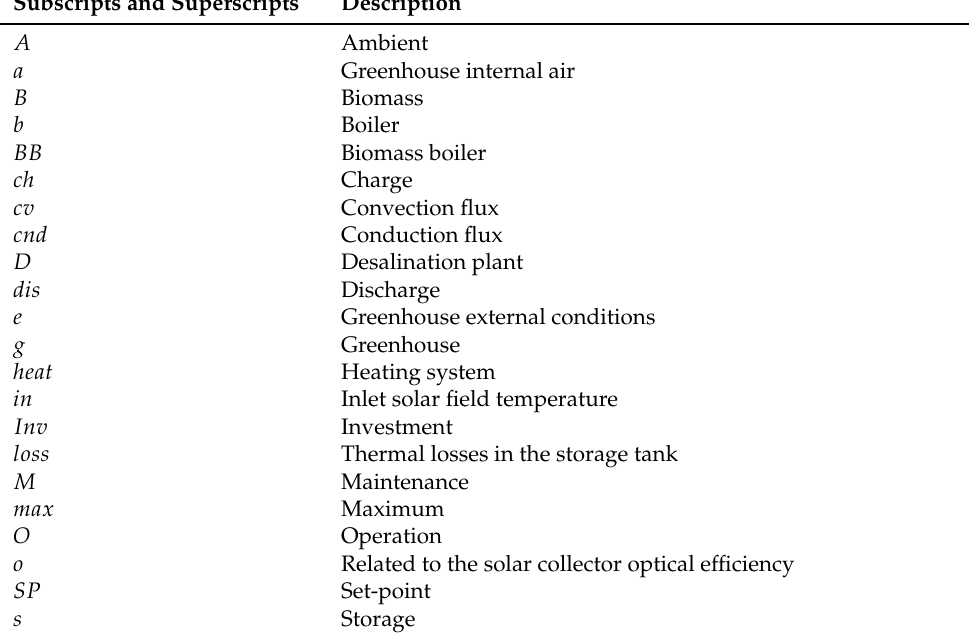
Table A2. Subscripts and